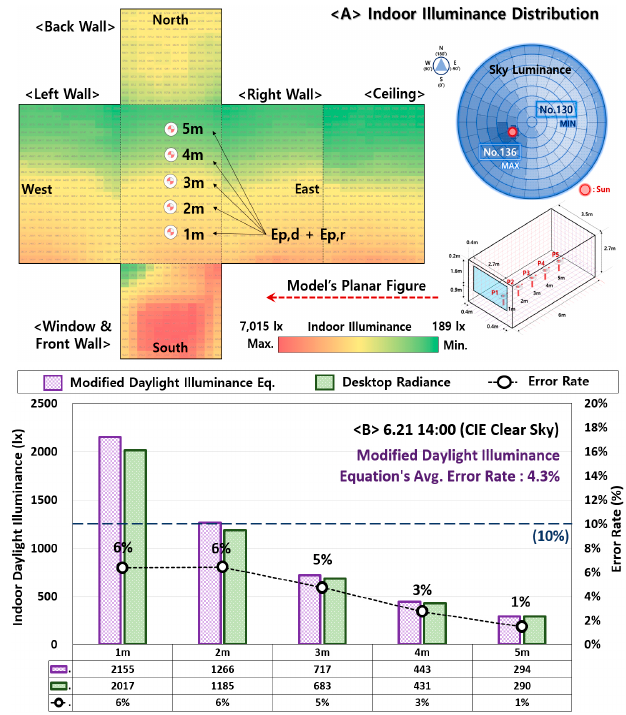
Figure 15. Indoor illuminance distribution of the six–side planar figure and comparison of illuminance between the modified equation and Desktop Radiance (CIE Clear Sky_6.21 14:00).